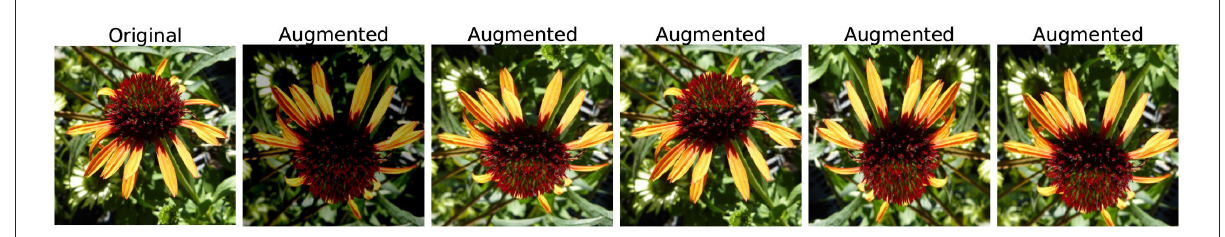
FIGURE3 Image augmentations—Horizontal and vertical flip, small brightness/contrast adjustments, and 80–100% crops—used while training the deep neural network classifier. Image by Zoya